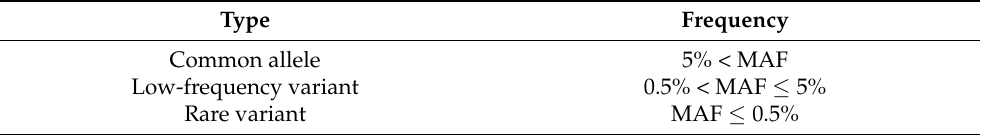
Table 5. Different classes of minor alleles based on